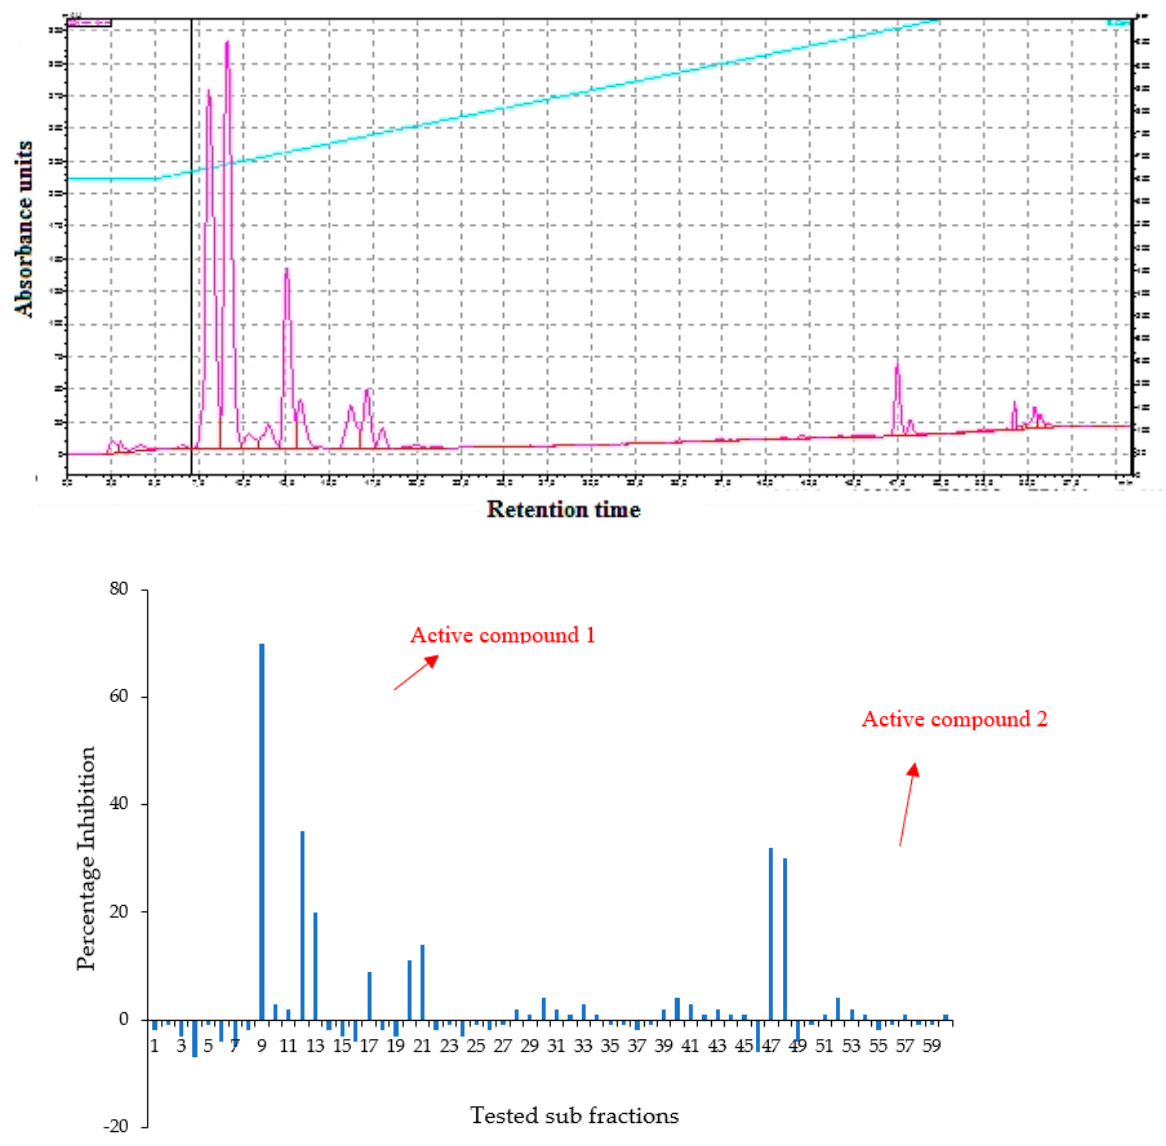
Figure 5. Top panel: HPLC chromatogram of fraction 49 of silica gel column; fractions were collected per minute and tested for activity (percentage inhibition of C. albicans ) ( bottom panel).